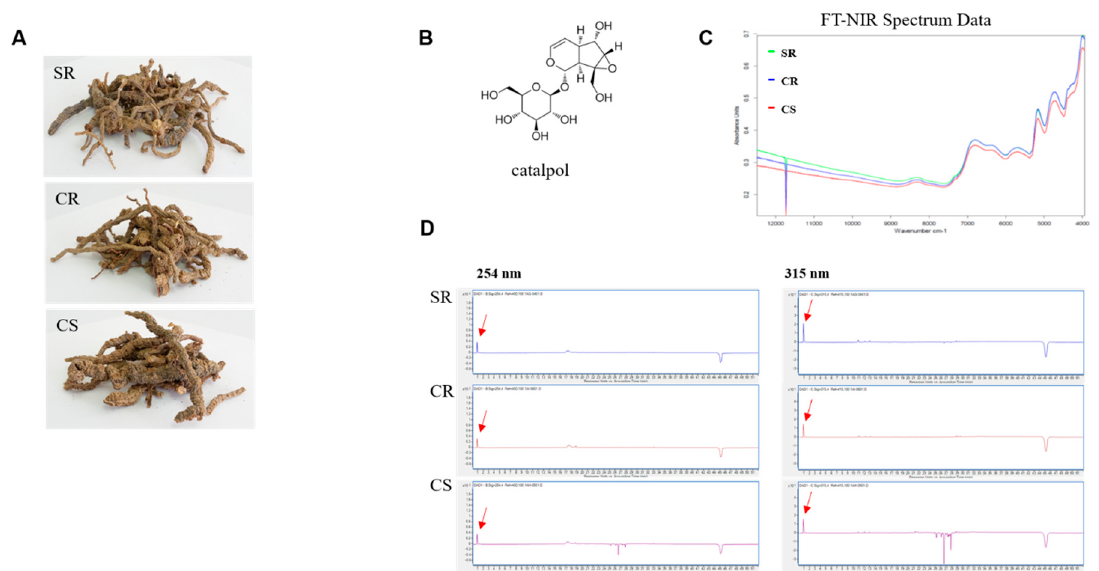
Figure 5. LC/MS analysis of three samples of R. glutinosa . ( A ) Three samples of R. glutinosa. SR, CR, and CS. ( B ) The structure of catalpol. ( C ) FT-NIR Spectrum (Green peak. SR, Blue peak. CR, Red peak. CS). ( D ) UV chromatogram of LC/MS for three samples (detection wavelength as 254 and 315 nm), catalpol (red arrow).